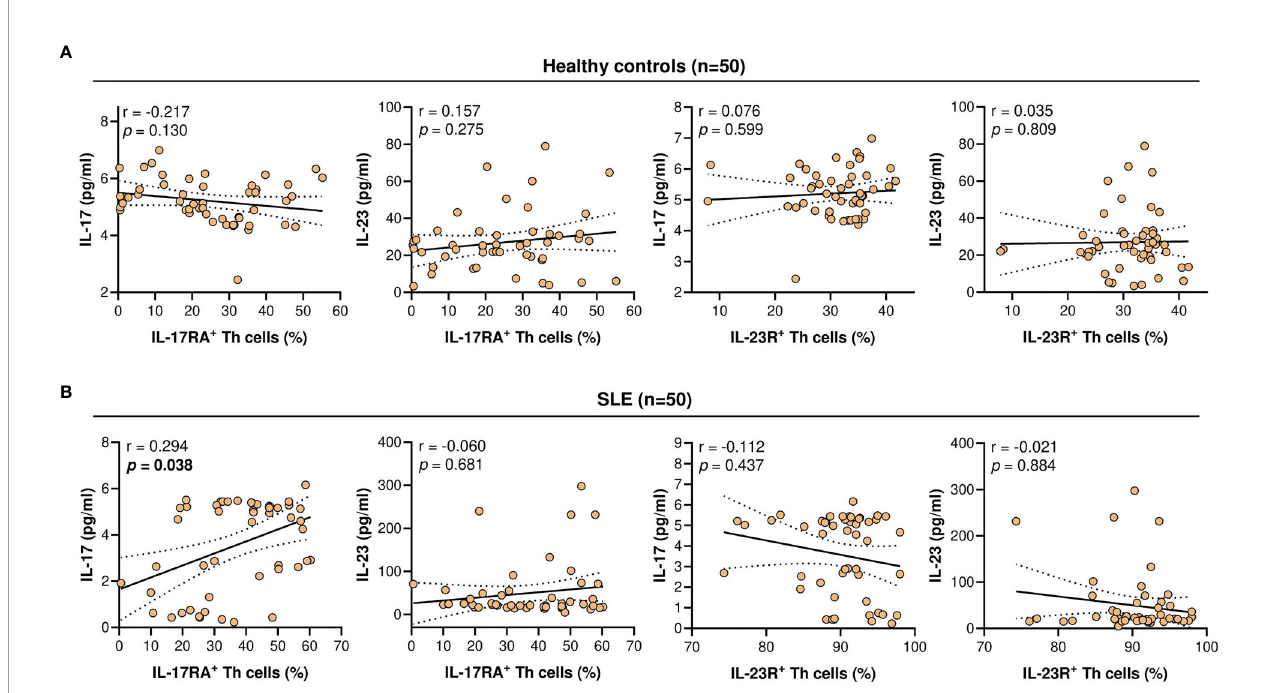
FIGURE 4 | Correlation of IL-17RA + or IL-23R + Th cells population (%) with serum IL-17 or IL-23 levels (pg/ml). (A) Correlation in healthy controls (n = 50). (B) Correlation in SLE patients (n = 50). For each graph, the linear regression plot is represented by a best- fi t line surrounded by adjacent 95% con fi dence